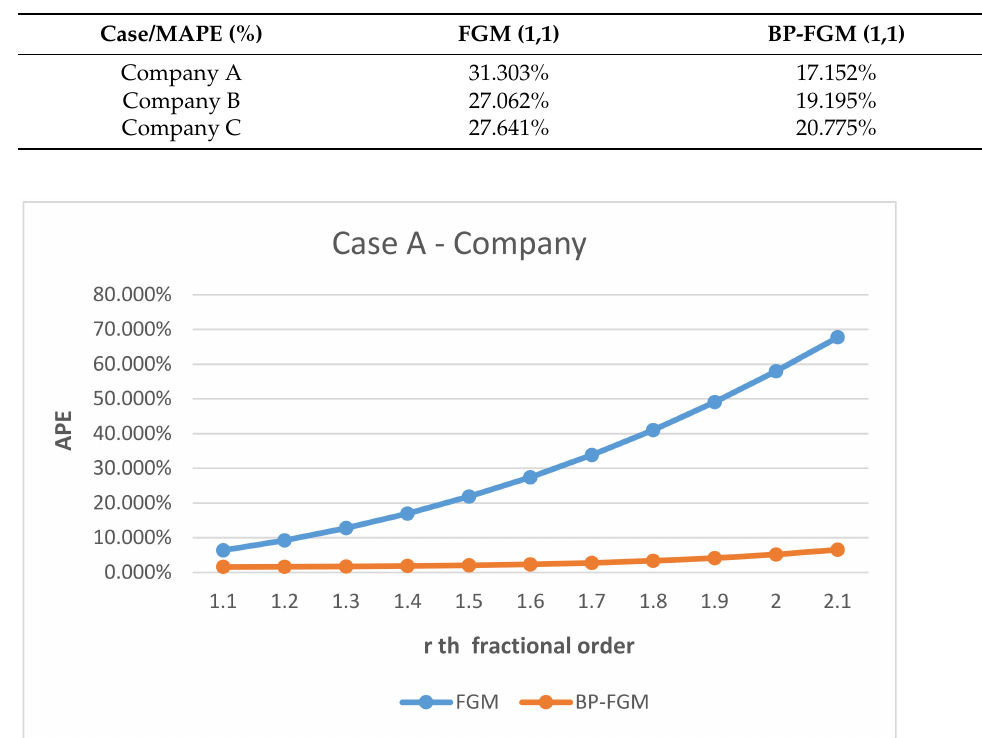
Figure 7. Representing the absolute percentage error for Case A by using the FGM and BP-FGM model.